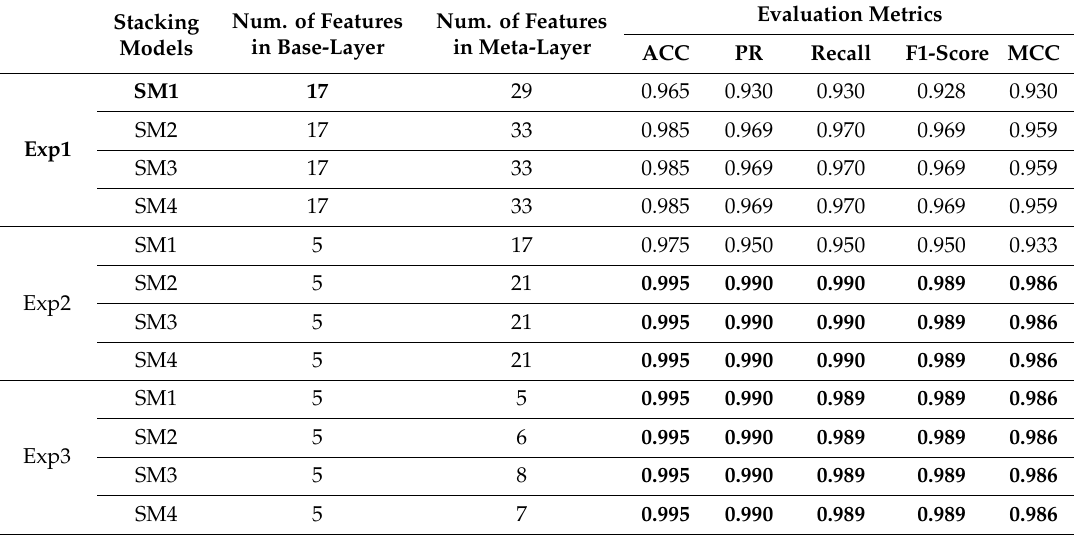
Table 4. Comparison of di ff erent stacking models on the CT scan dataset through the 10-fold CV (see Appendix A, Table A2 for further